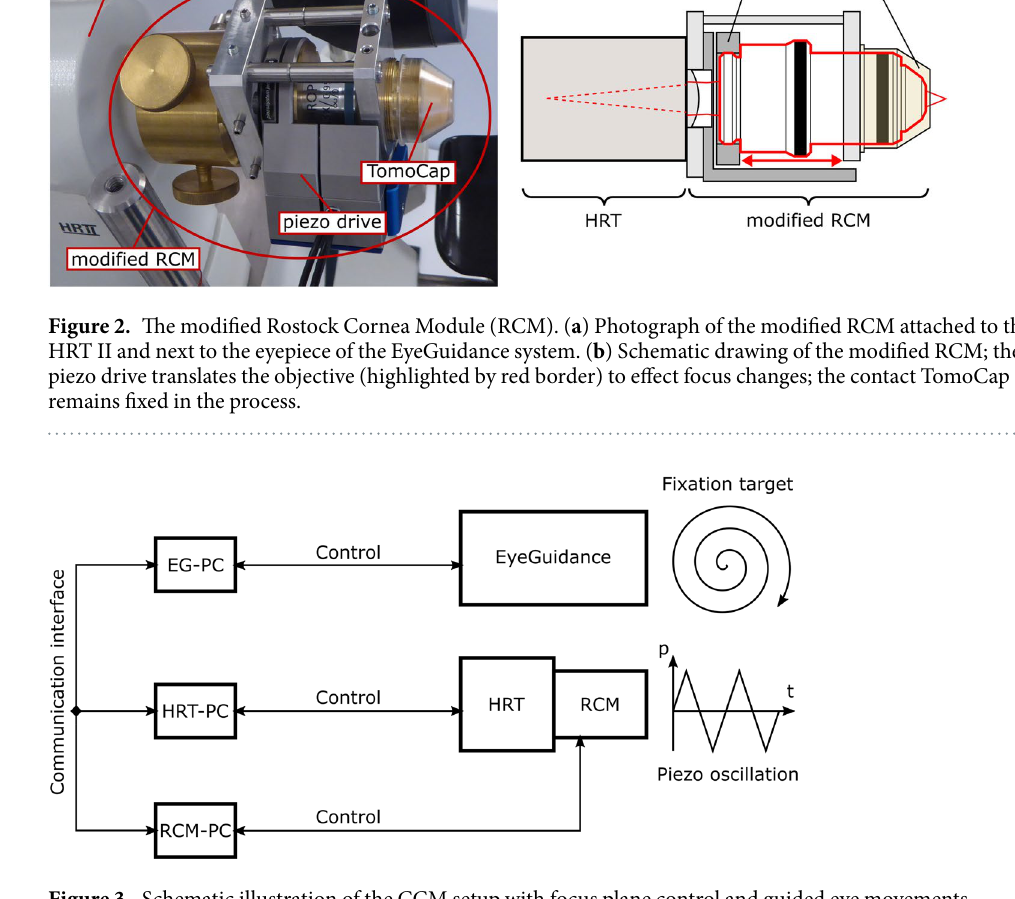
Figure 3. Schematic illustration of the CCM setup with focus plane control and guided eye